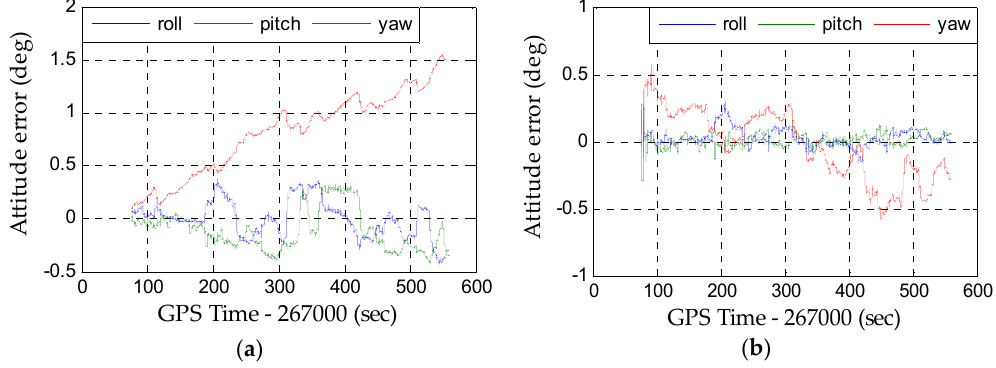
Figure 18. Attitude error. ( a ) INS-only solution; ( b ) Vision-aided INS solution.